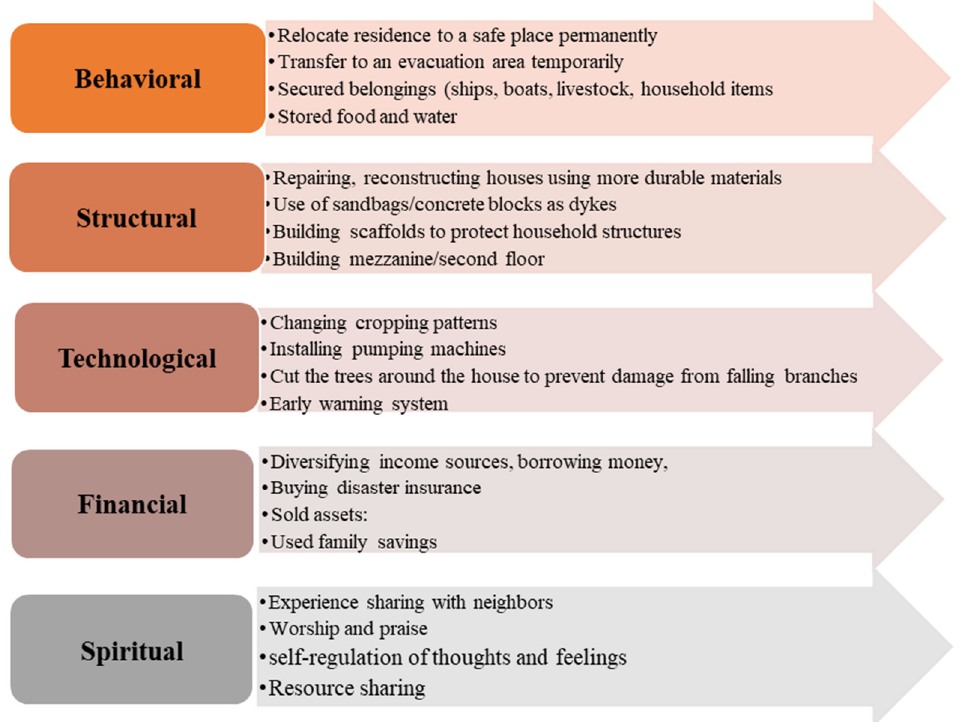
Figure 3. Coping strategies adopted by coastal households during extreme weather events